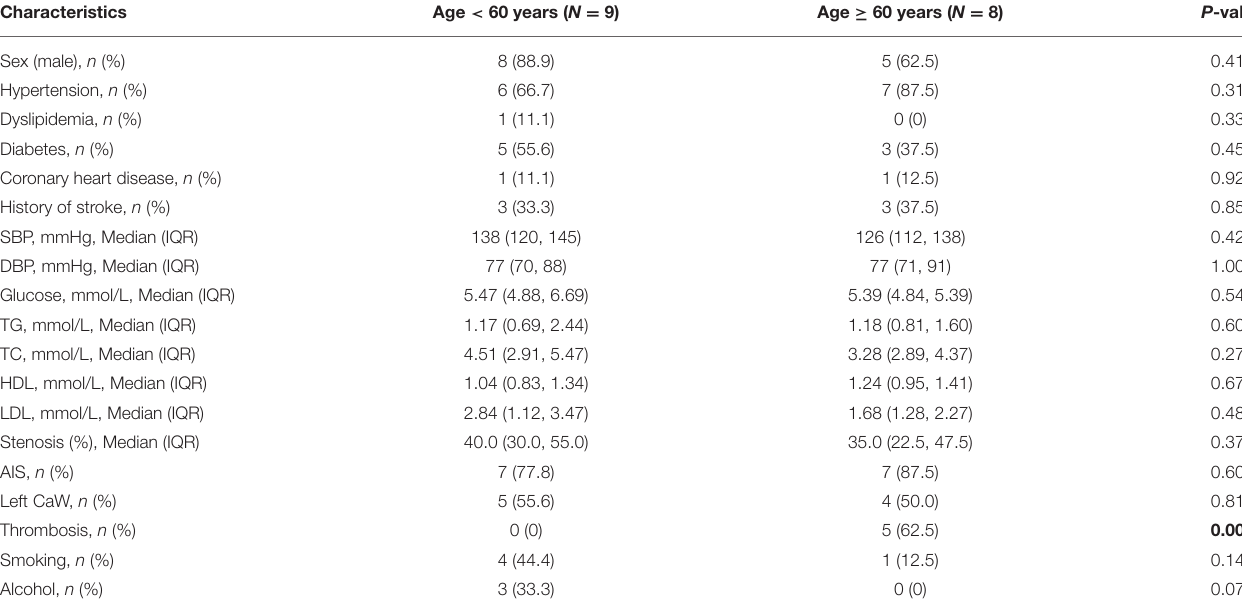
TABLE 2 | Comparison of characteristics between the < 60 years old CaW group and the ≥ 60 years old CaW group. Characteristics